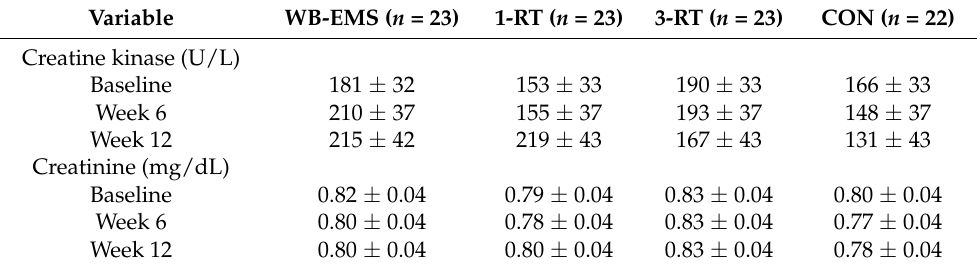
Table 6. Blood markers of muscle status and renal function at baseline, week 6 and week 12. Variable